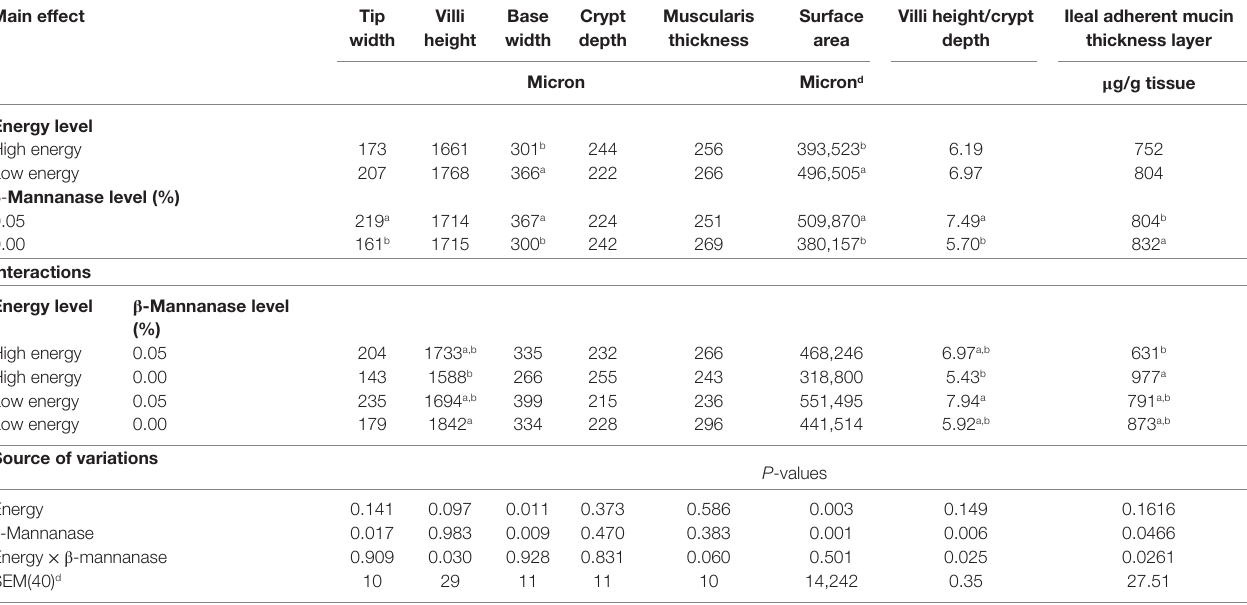
TaBle 3 | effect of dietary energy level and β -mannanase supplementation on jejunum villi morphological characteristics and ileal adherent mucin thickness layer of turkey hens at 28 days of age.